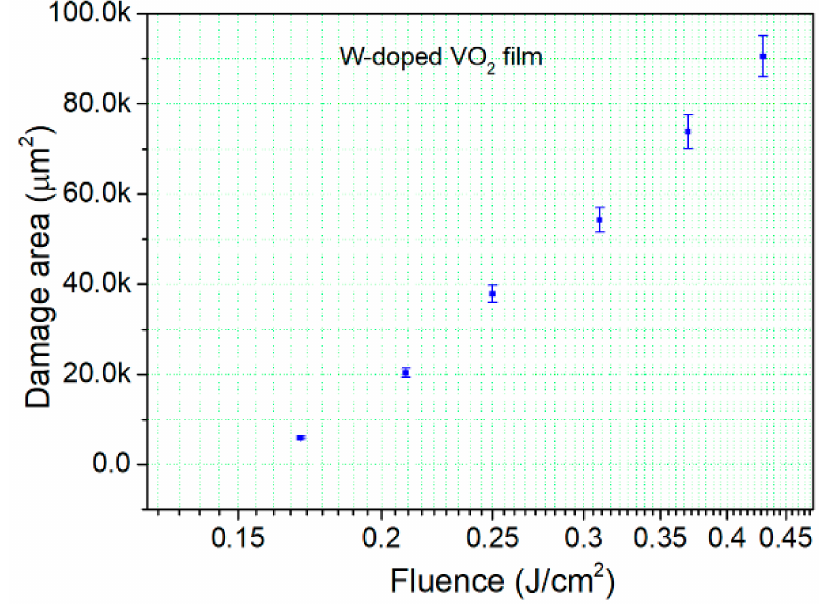
Figure 9. Damage area as a function of the fluence for the W-doped VO 2 film; the error bars were obtained using the practically measured energy